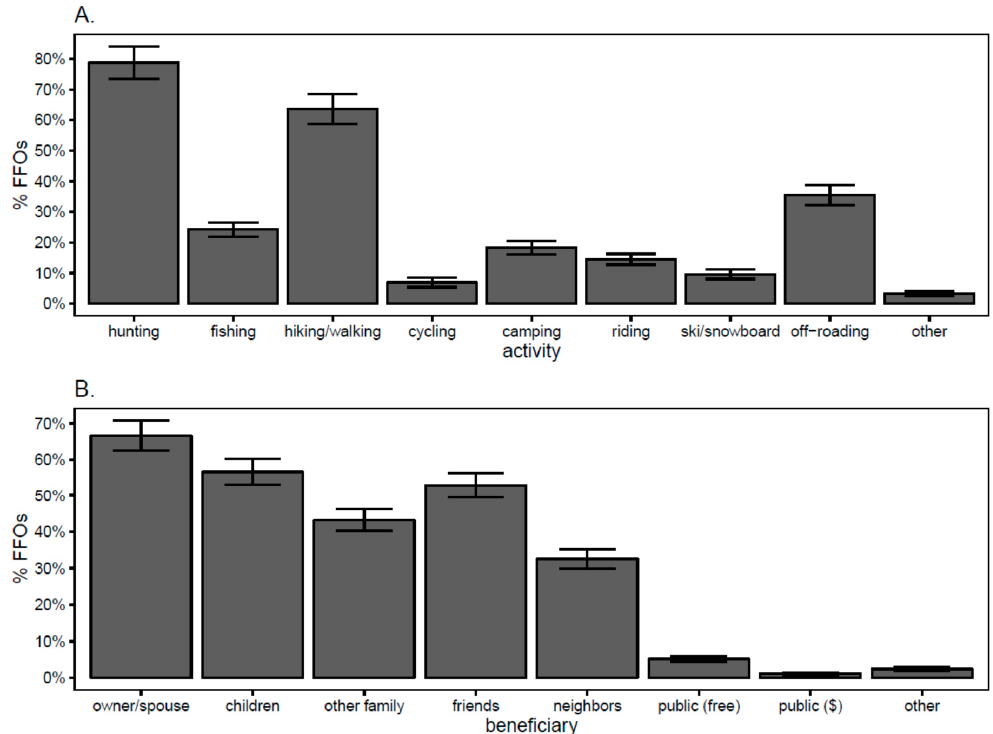
Figure 5. Estimated proportion of family forest ownerships (4+ ha) providing a selection of recreational services in the past 5 years by ( A ) recreational activity and ( B ) beneficiary, United States, 2011–2013. Error bars represent two standard errors. Proportions in ( A ) are relative to the total number of ownerships; proportions in ( B ) are relative to the total number of ownerships providing recreational services.